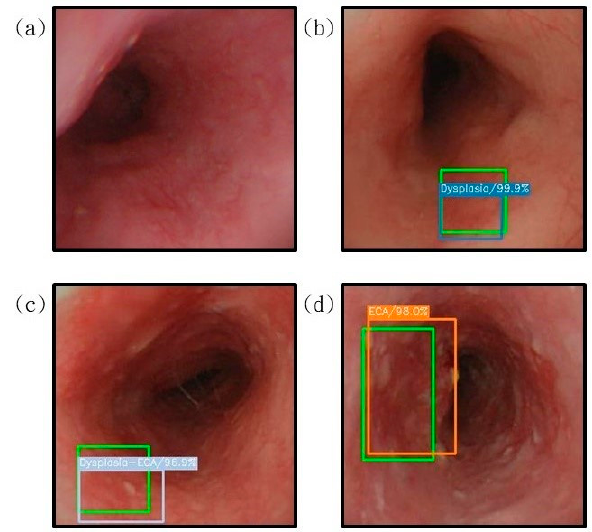
Figure 4. The results of the prediction of esophageal cancer on the white-light endoscopic imaging. The correct position is represented by green rectangle is shown for comparison with the predicted result. ( a ) The result of the esophagus test is normal. It is not displayed under the diagnosis of SSD. ( b ) represents the detection result of the area with low-grade dysplasia, under the diagnosis of SSD, the blue bounding box surrounds the lesion area; ( c ) shows the area with high-grade dysplasia. The test result shows that the gray bounding box surrounds the lesion area under the diagnosis of SSD; ( d ) shows the detection result of the invasive cancer area, and the orange bounding box surrounds the lesion area under the diagnosis of SSD.